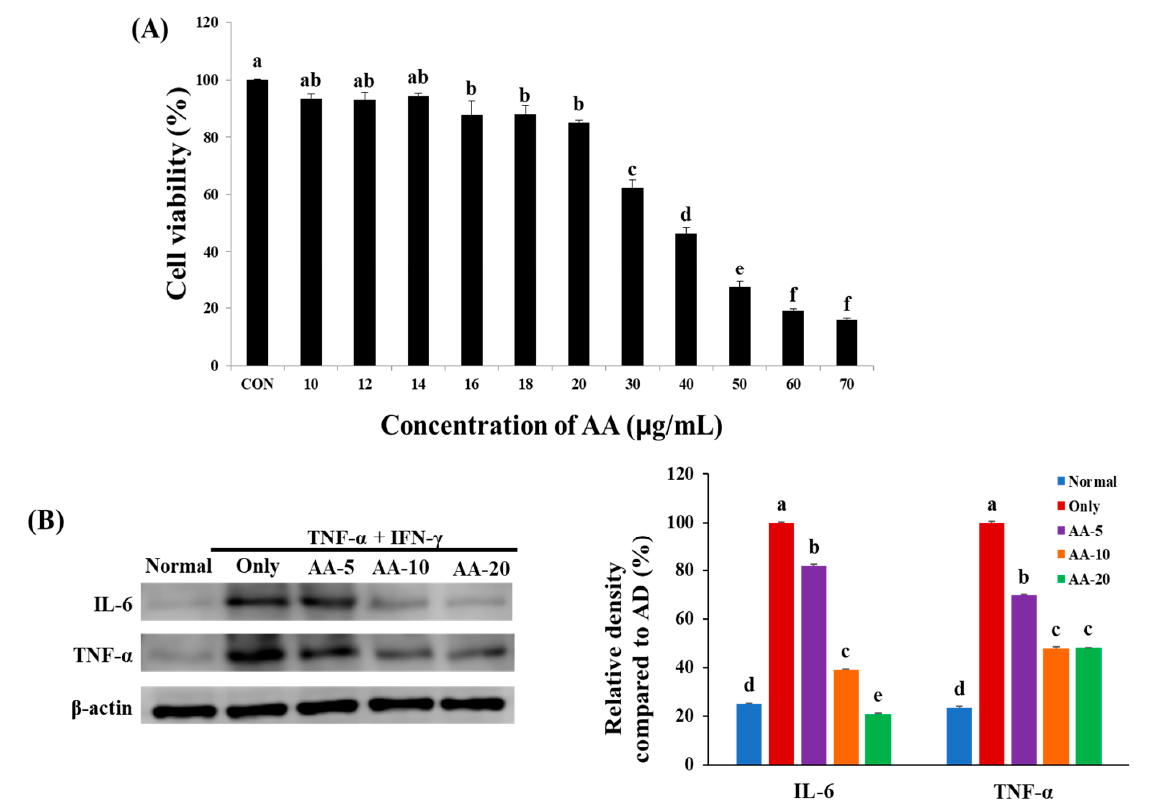
Figure 2. To evaluate the effect of asiatic acid (AA), ( A ) cell viability in HaCaT cells was examined using the 3-(4,5-dimethylthiazol-2-yl)-2,5-diphenyltetazolium bromide assay. CON, control. ( B ) Effects of AA on the inflammation mechanism of tumor necrosis factor (TNF)- α - and interferon (IFN)- γ -treated HaCaT cells. According to Duncan’s multiple range test, significant values are indicated by different letters ( p < 0.05), and values express the mean ± standard deviation ( n = 3). Normal, control cells; Only, 20 ng/mL TNF- α - and IFN- γ -treated cells; AA-5, -10, and -20, cells pretreated with 5, 10, and 20 µg/mL AA, respectively, and then treated with 20 ng/mL TNF- α and IFN- γ .